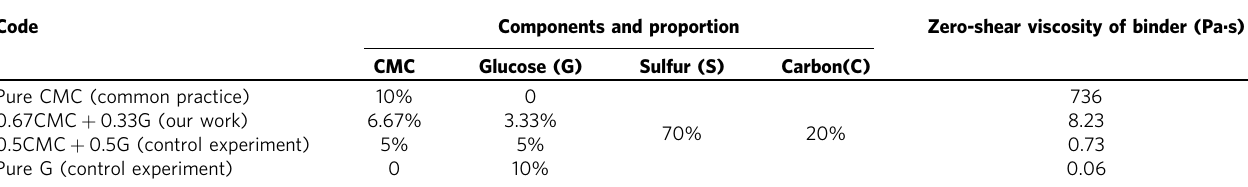
Table 1 Description of the cathodes with different binder